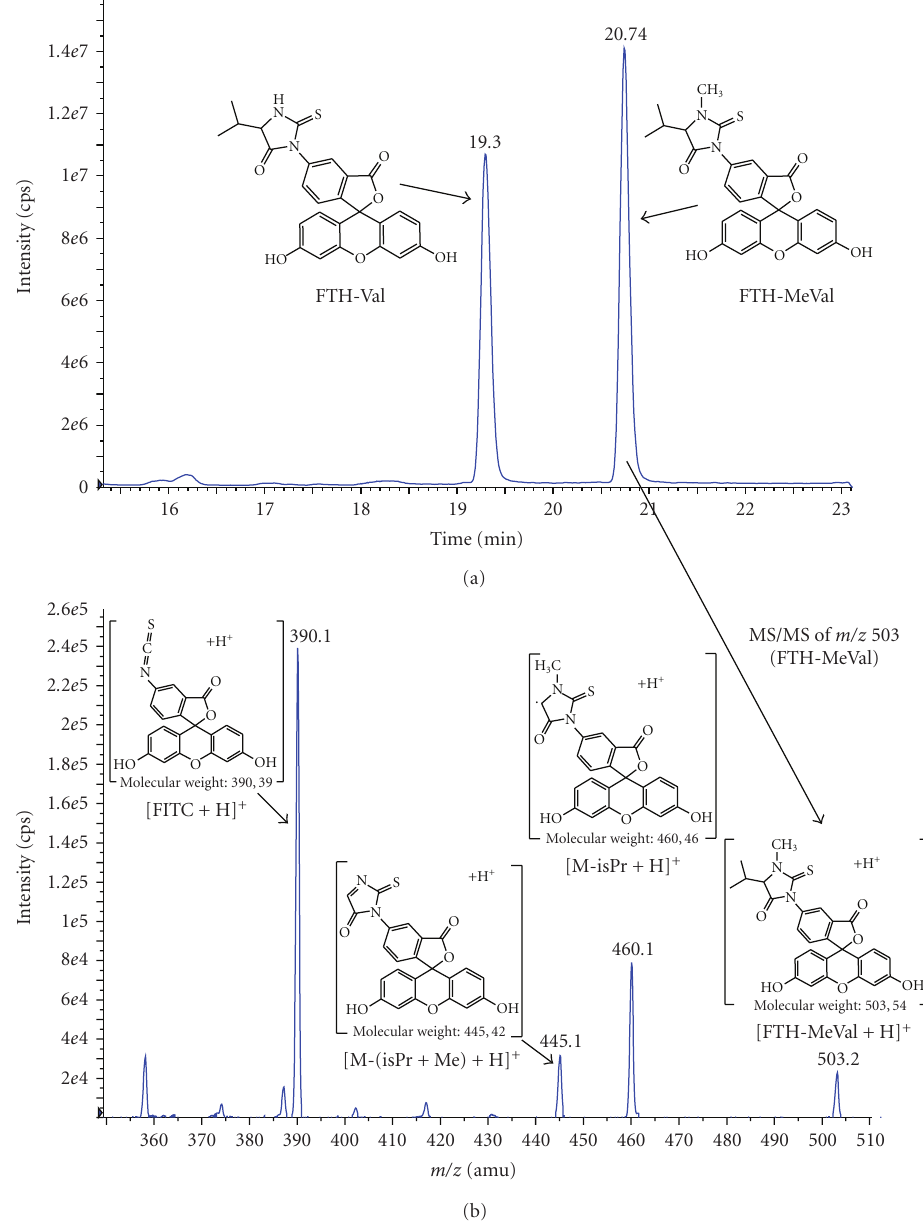
Figure 4: Expanded view of an LC-MS (TIC) chromatogram of standards 1 and 2 (a) and an LC-MS/MS spectrum of m/z = 503 (FTH- MeVal)